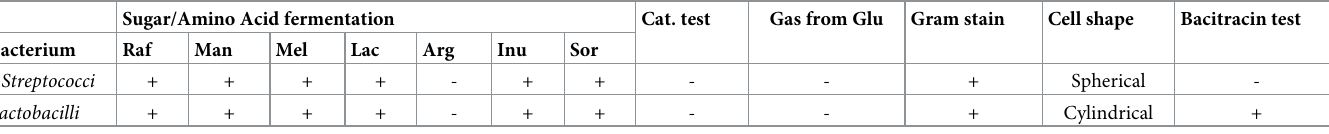
Table 1. Biochemical and physical test results against S . mutans and Lactobacillus collected from saliva. Sugar/Amino Acid fermentation